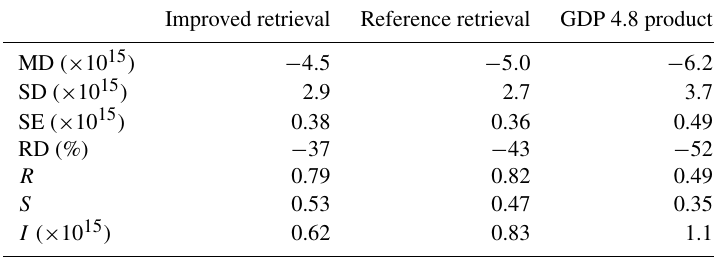
Table B2. Similar to Table B1 but for the urban Uccle station for a total of 57 monthly points.